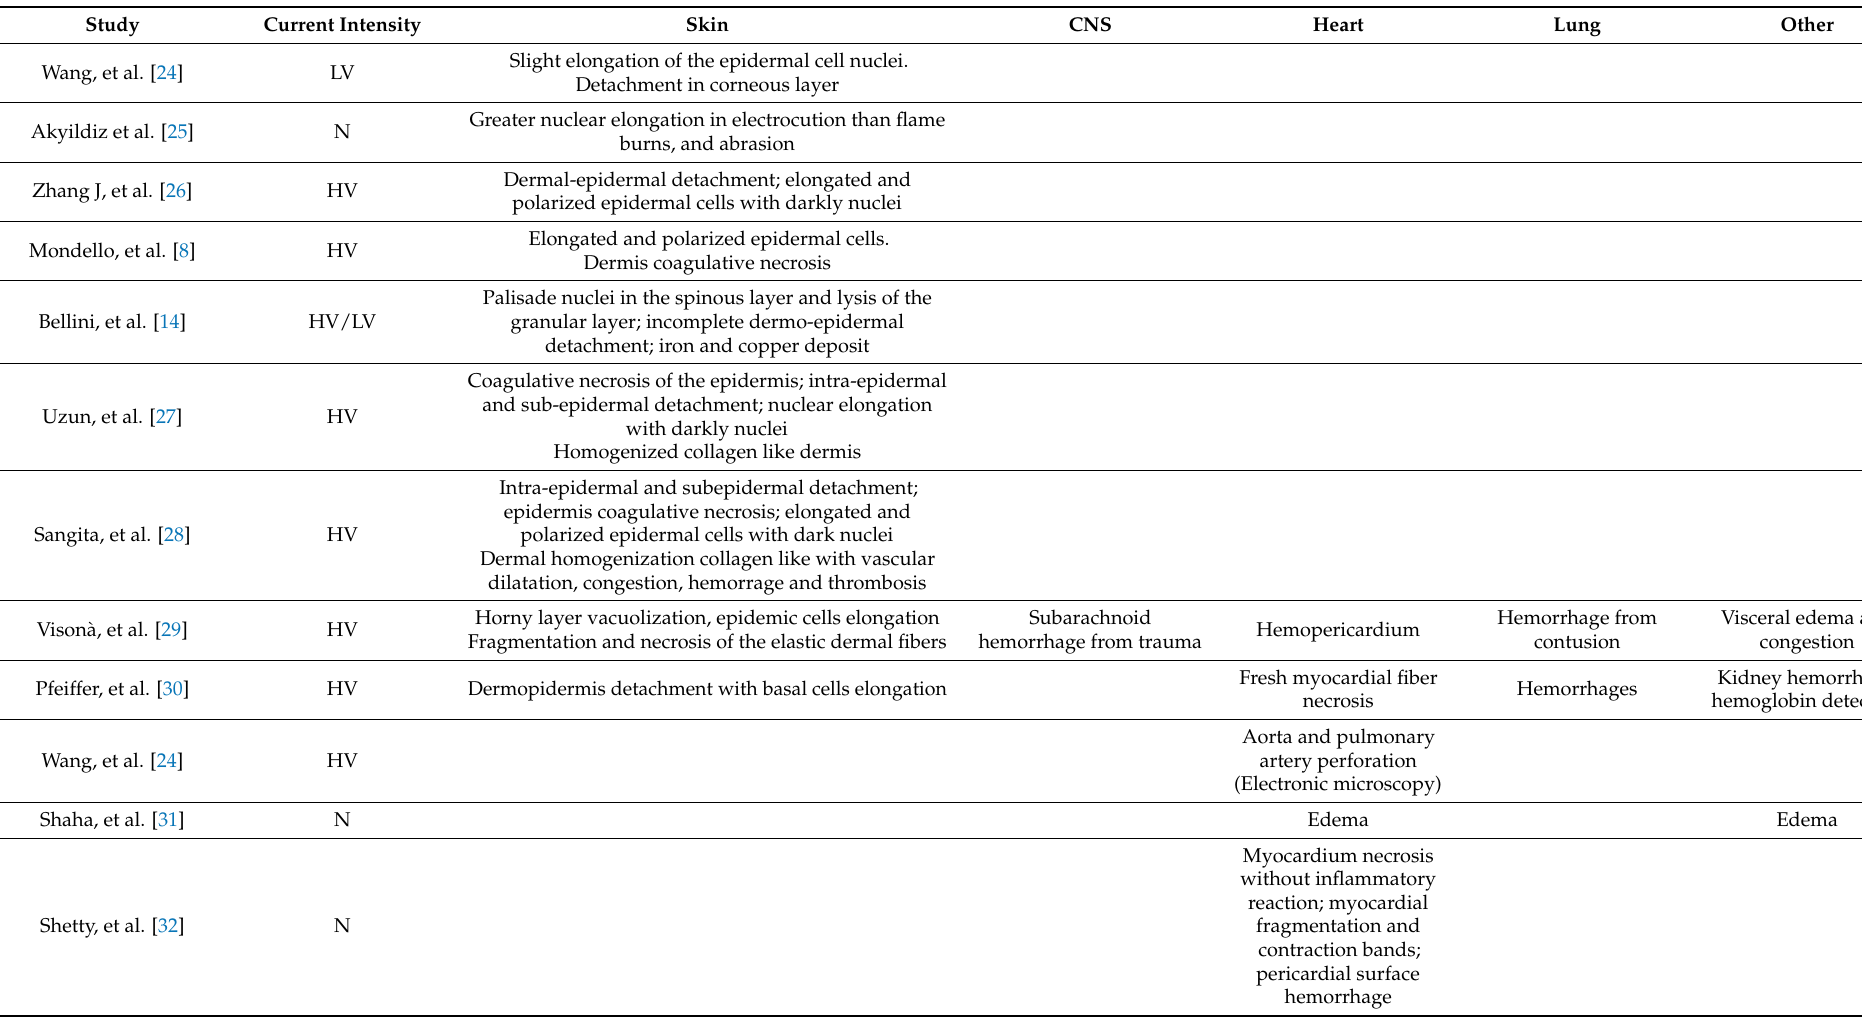
Table 2. Histological findings from autopsy